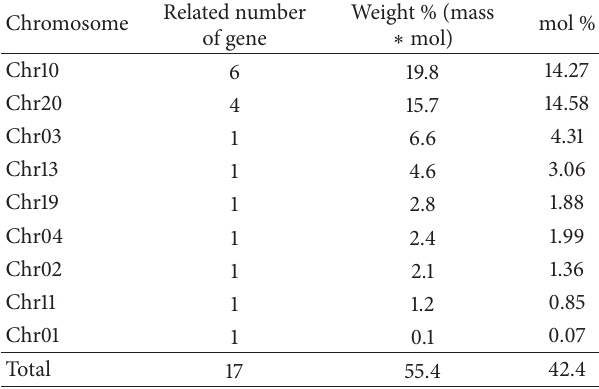
Table 2: Composition of storage proteins in G. max cv.